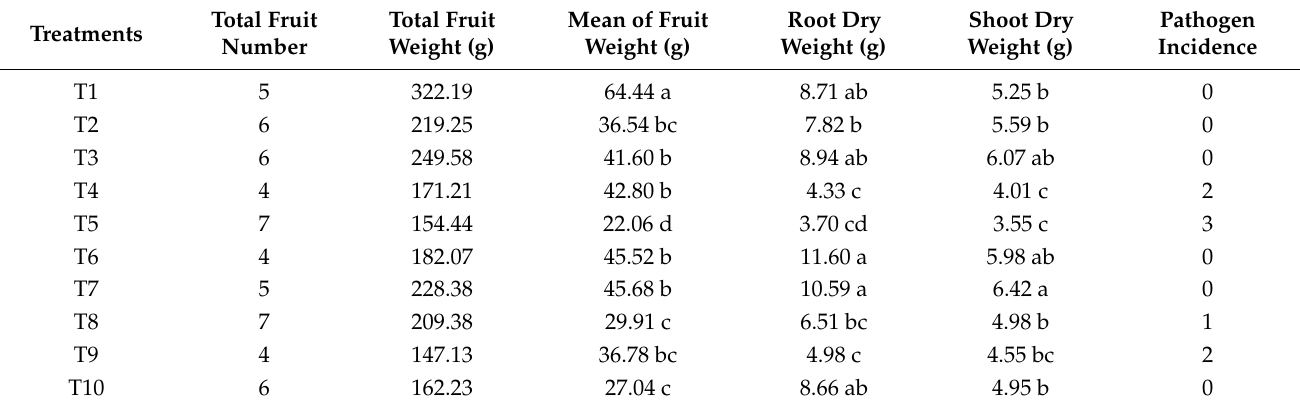
Table 4. Fruit production, plant dry weight and R. solani and P. capsici incidence on pepper plants under CT application. Total Treatments